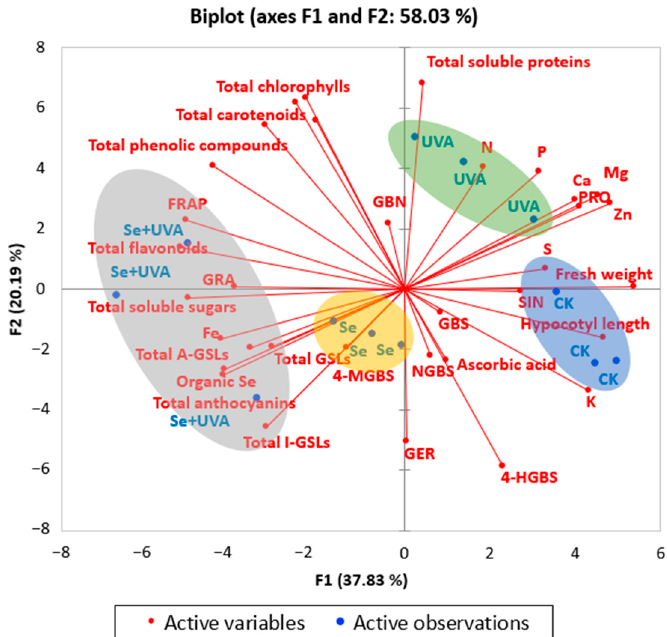
Figure 8. Loading plot and scores of PCA for fresh weight, hypocotyl length, total chlorophylls, total carotenoids, total anthocyanins, total soluble proteins, total soluble sugars, total phenolic com- pounds, total flavonoids, ascorbic acid, FRAP, total GSLs, total A-GSLs, total I-GSLs, individual GSL (PRO, GRA, SIN, 4-HGBS, GBN, GER, GBS, 4-MGBS, and NGBS), and minerals concentrations (N, P, K, Ca, Mg, S, Fe, Zn, and organic Se) in broccoli microgreens grown under Se and/or UVA treat-